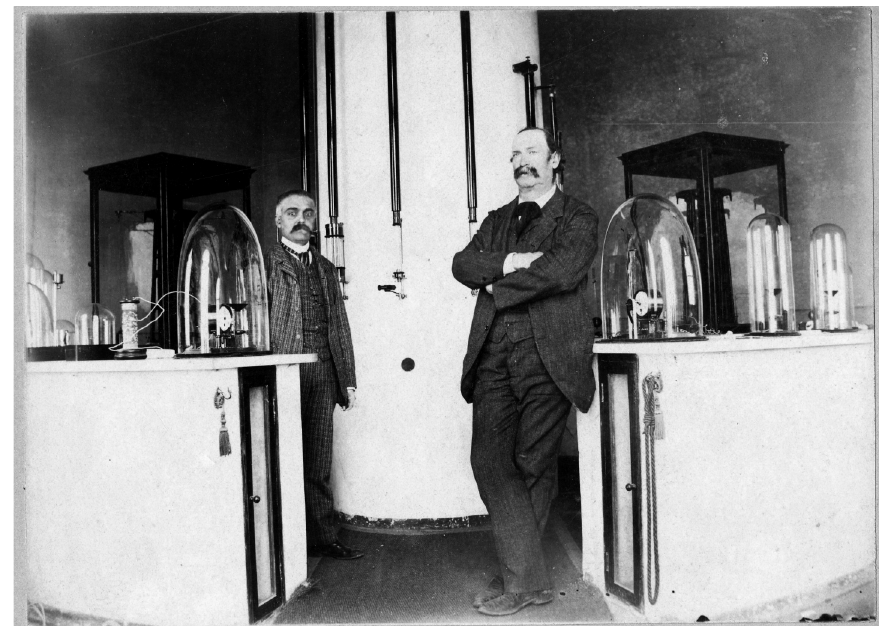
Fig. 6. Michele Stefano De Rossi and his assistant at the Rocca di Papa Observatory in a picture dating back to the 1890s (De Rossi Private Archive,